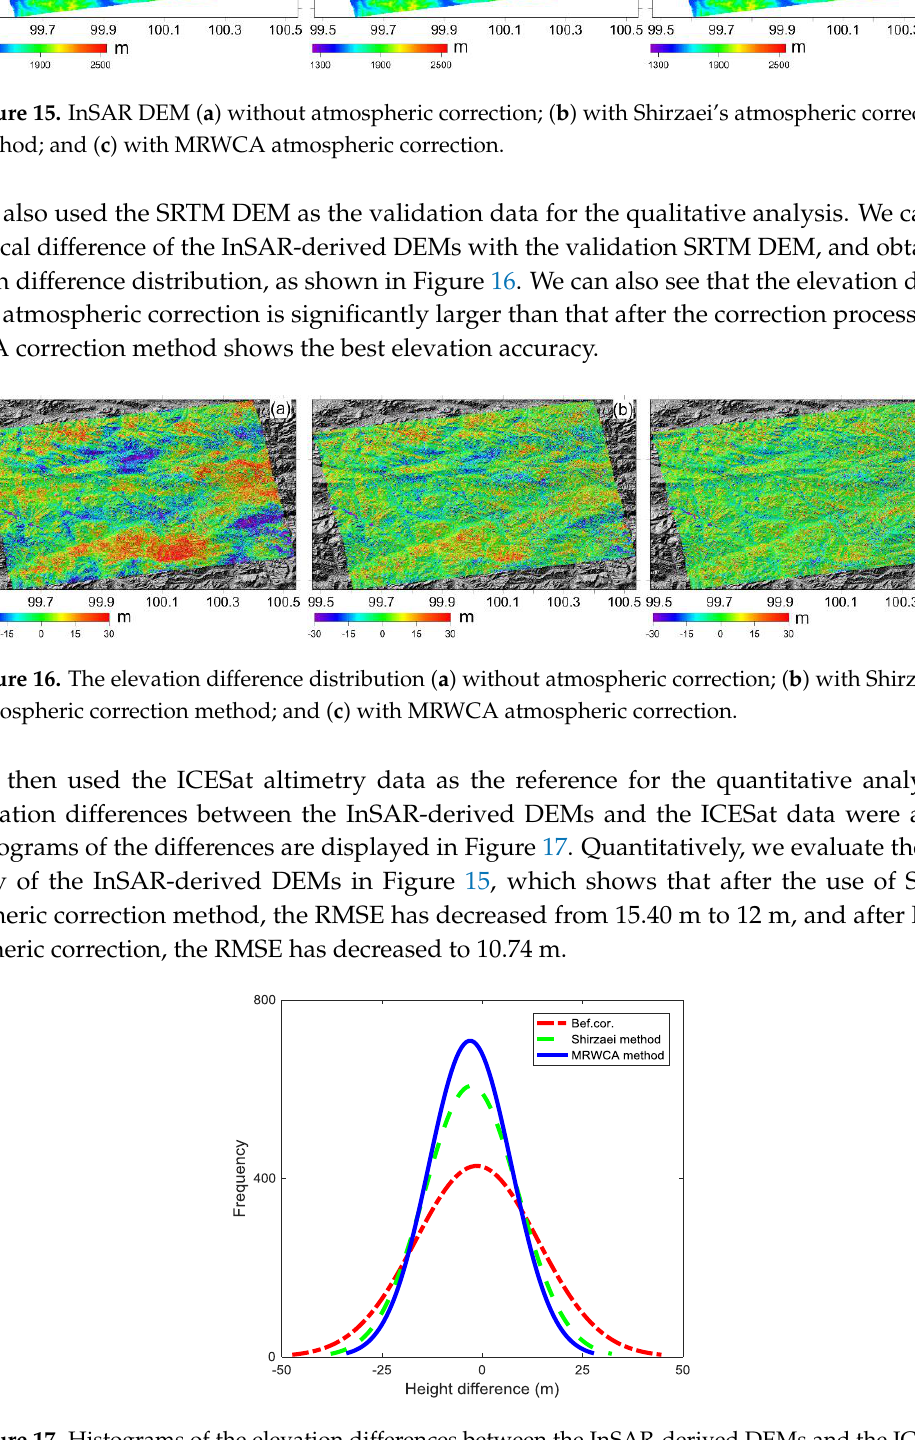
Figure 17. Histograms of the elevation differences between the InSAR-derived DEMs and the ICESat data, generated without ATP correction, with Shirzaei’s atmospheric correction method, and with MRWCA atmospheric correction.